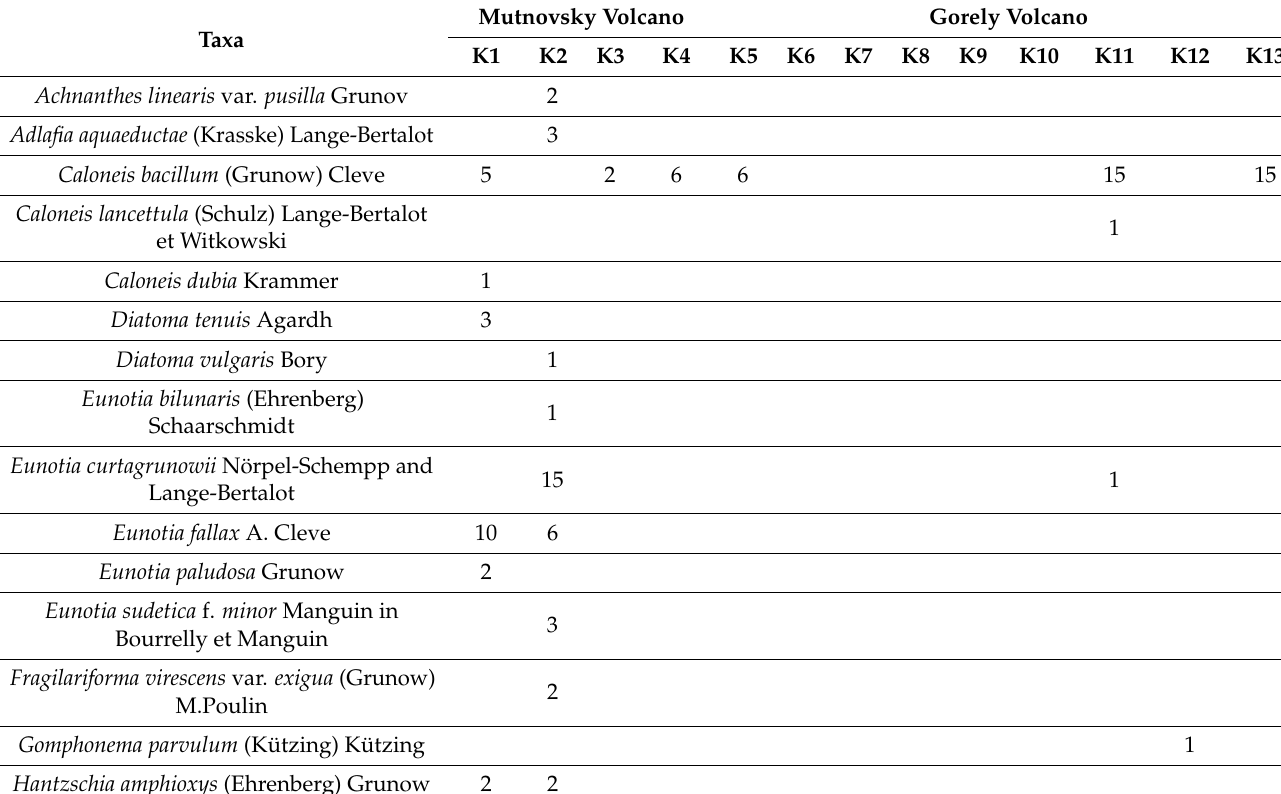
Figure 3. Species of diatoms from Mutnovsky and Gorely volcano soils: ( A ) Achnanthes linearis var. pusilla ; ( B ) Adlafia aquaeductae ; ( C ) Caloneis bacillum ; ( D ) Caloneis dubia ; ( E ) Caloneis lancettula ; ( F ) Eunotia curtagrunowii ; ( G ) Eunotia fallax ; ( H ) Gomphonema parvulum ; ( I ) Hantzschia amphioxys ; ( J ) Humidophila contenta ; ( K ) Luticola mutica ; ( L ) Nitzschia cf. ovalis ; ( M ) Nitzschia palea ; ( N ) Pinnularia borealis ; ( O ) Pinnularia intermedia ; ( P ) Pinnularia sp.1; ( Q ) Pinnularia sp.2; ( R ) Pinnularia cf. subcapitata; ( S ) Planothidium lanceolatum ; ( T ) Platessa oblongella ; ( U ) Psammothidium ventrale ; ( V ) Sellaphora bacillum ; ( W ) Tabularia fasciculata . Table 2. Sampling sites. Table 3. Diatom taxa recorded at each sampling